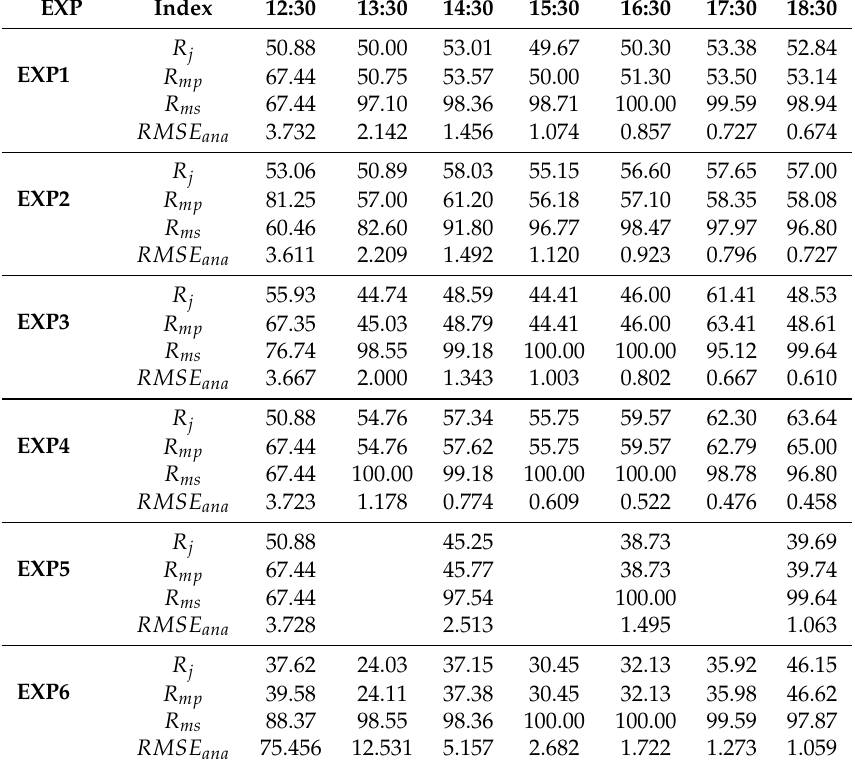
Table 4. Indices R j , R mp and R ms calculated for each experiment and assimilation time. RMSE ana (t) is the root mean square error of the analyzed states. A decrease in RMSE ana can be observed for all the